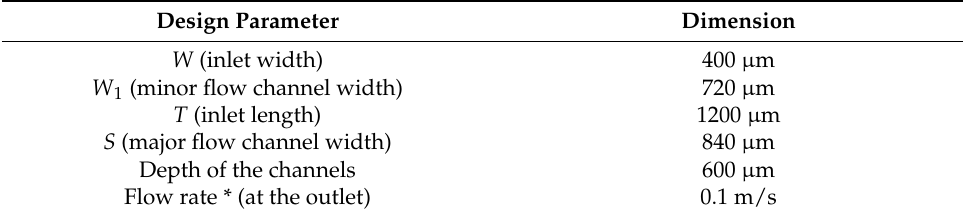
Table 1. Design parameters of the virtual impactor.